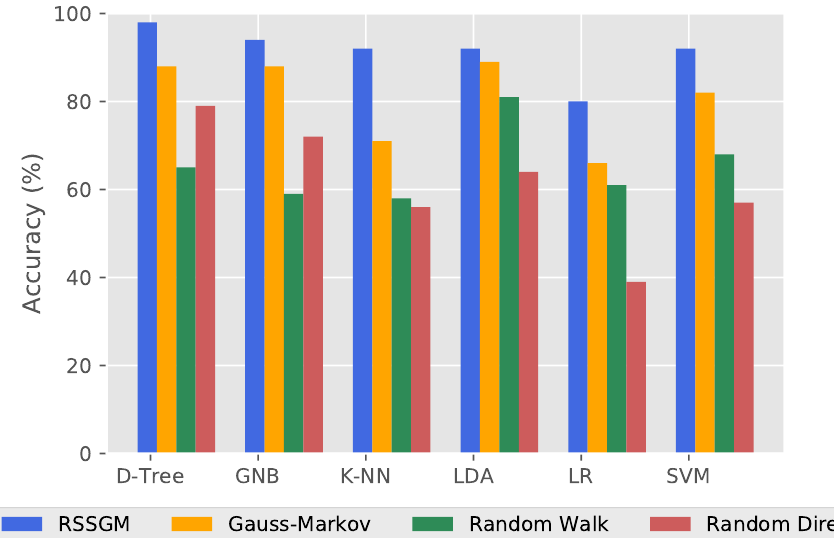
Figure 9. Total average